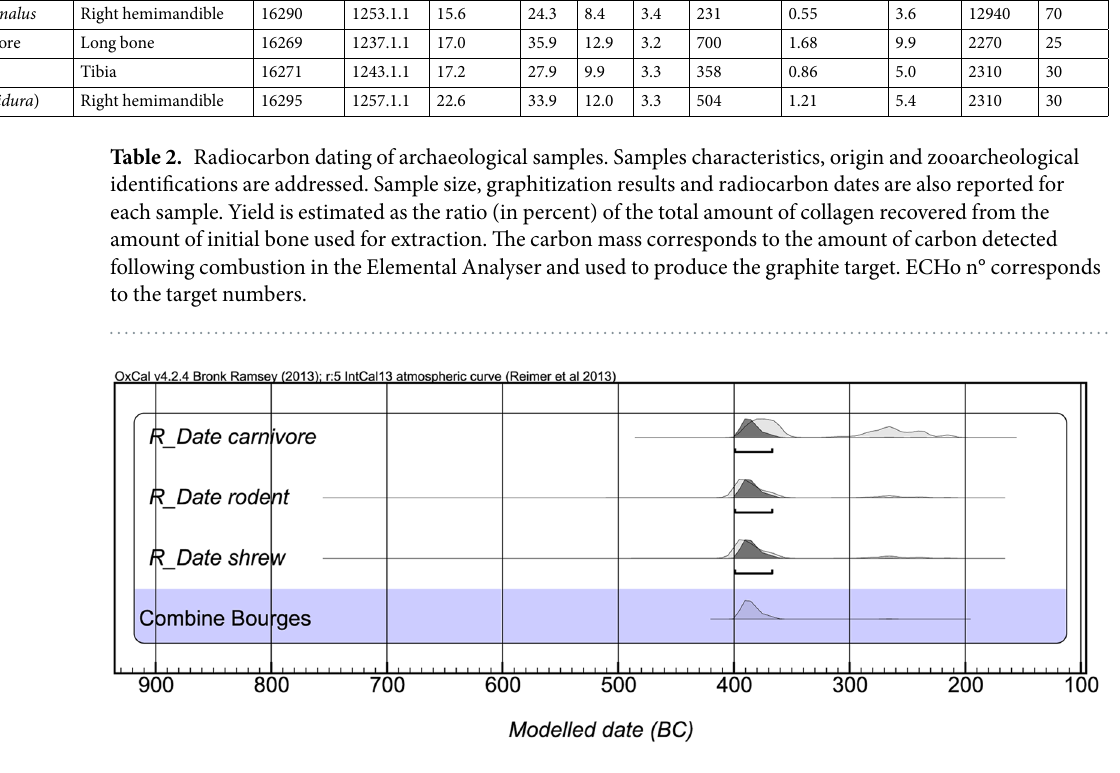
Figure 3. Calibration and Bayesian modeling of the three AMS dates on small mammal samples from Bourges (France). Dates were modelled in OxCal v.4.2.4 56 using IntCal13 atmospheric curve 57